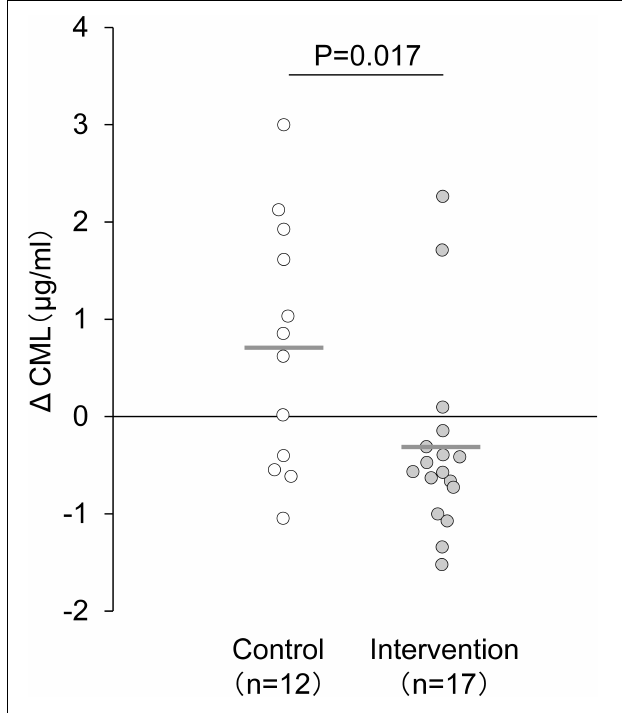
FIGURE 2 | Changes in serum CML level after 12-week exercise intervention. The delta value was calculated as the postintervention value minus the baseline value. The mean decrease in serum CML level was significantly larger in the intervention group than in the control group. Horizontal bars indicate mean values. Changes in CML level between the intervention and control groups were compared using an unpaired t -test (Yoshikawa et al.,